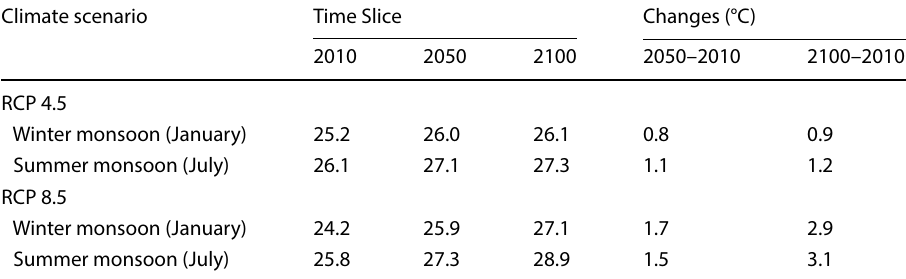
Table 5 Mean surface temperature (°C) under RCP 4.5 and RCP 8.5